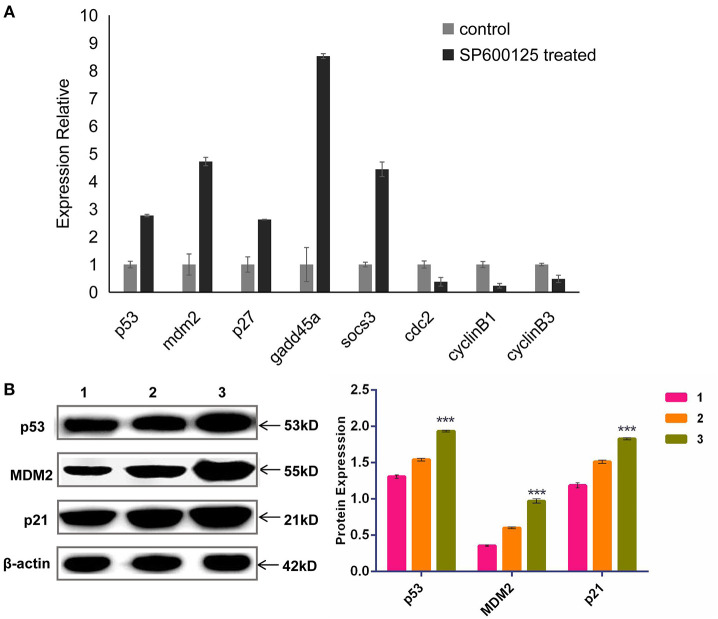
Expression levels of p53 pathway genes in SP600125-treated cells. (A) The mRNA levels of p53-relevant genes detected by qRT-PCR. (B) The expressed levels of p53 pathway detected by Western blot, where “1” represents the control group (being cultured without SP600125), “2” represents the cells treated by SP600125 for 48 h, and “3” stands for the cells being treated first by SP600125 for 48 h and then being further cultured for 12 h in SP600125-free medium. Each bar represents the mean ± SD of three independent experiments (*P < 0.05).